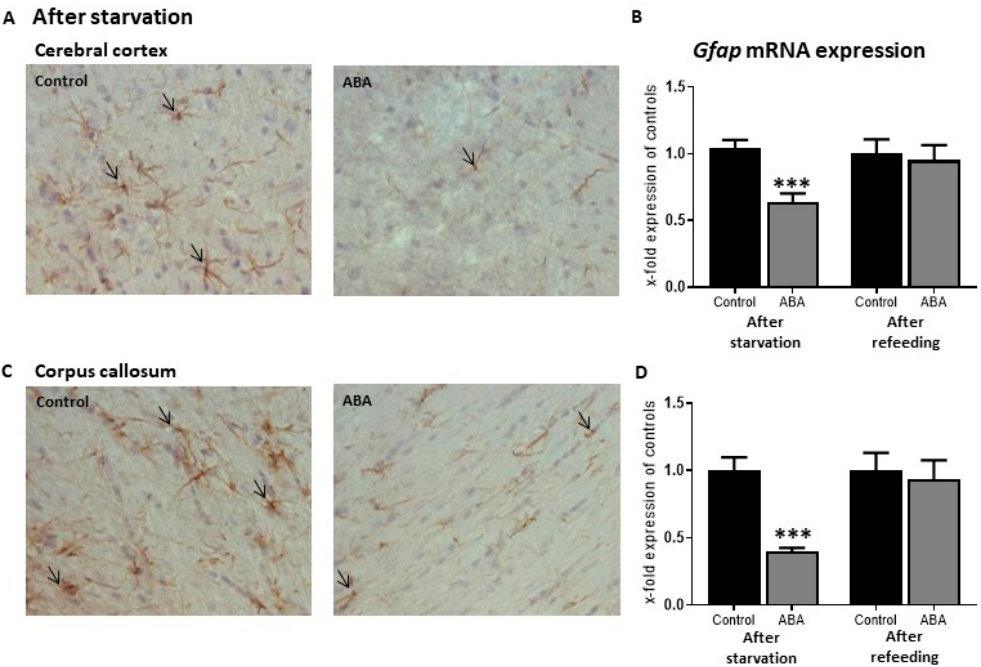
Figure 4. Effects of chronic starvation on GFAP + cell densities in the cerebral cortex ( A ) and the corpus callosum ( C ) in activity-based anorexia (ABA) rat model. The arrows mark GFAP + astrocytes. GFAP + cell densities and mean mRNA expression of Gfap were reduced after starvation in the ABA group compared to the control group. After refeeding Gfap mRNA expression was reversed to control levels in both brain regions ( B , D ). *** p ≤ 0.001, two-sided student’s t -test. Modified from Frintrop et al.,